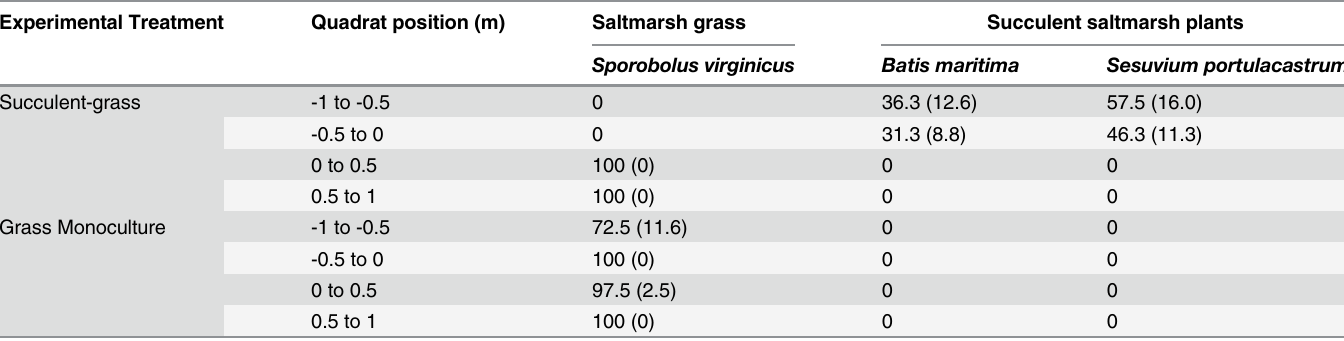
Table 1. Saltmarsh plant abundance within experimental